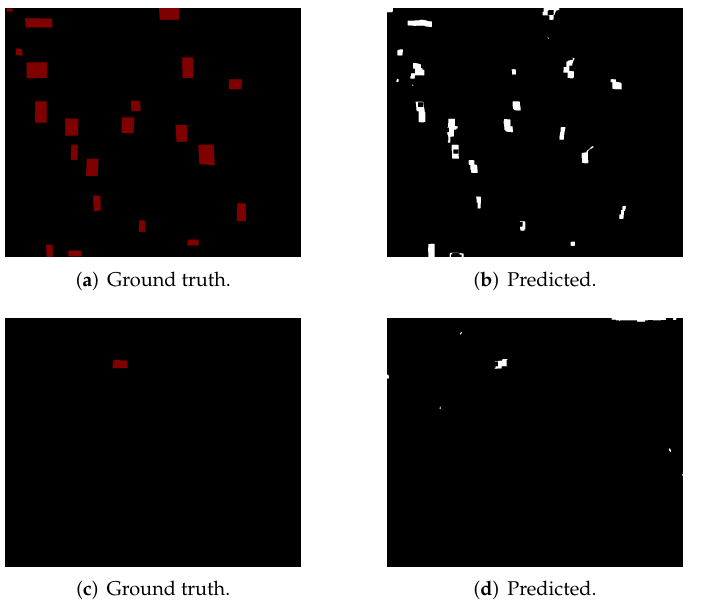
Figure 5. Examples of ( a , c ) ground truth and ( b , d ) the corresponding predicted saliency of input slide regions shown as binary